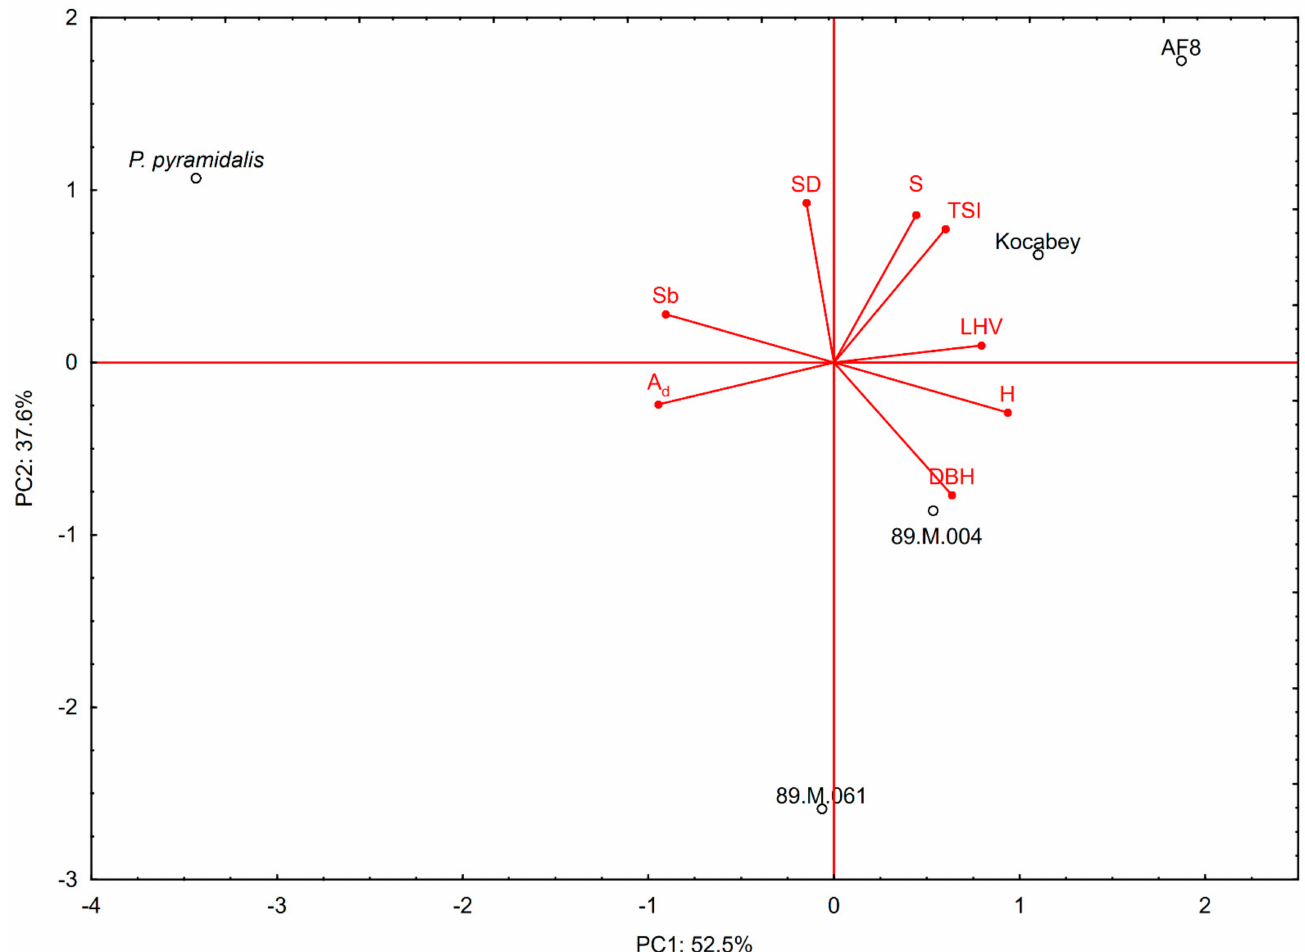
Figure 4. Principal component analysis (PCA) plot showing the multivariate variation poplar clones for productivity and biomass characteristics. Vectors indicate the direction and strength of each variable to the overall distribution. S, survival; TSI, self-ignition temperature; LHV, lower heating value; H, height; DBH, diameter at breast height; A d , ash mass fraction; Sb, bark mass fraction; SD, specific